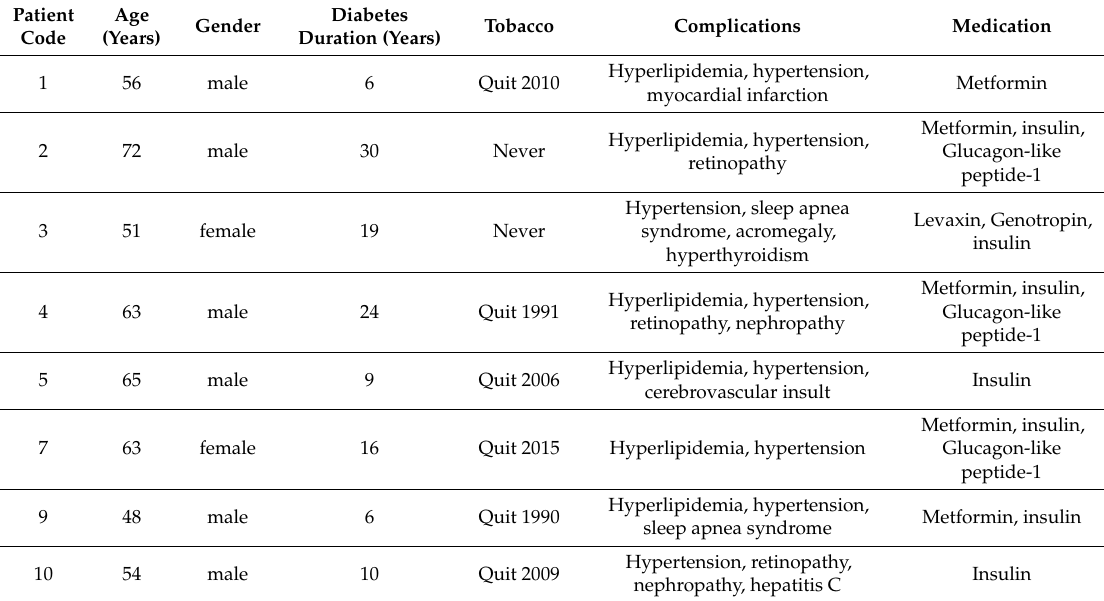
Table 1. Baseline data of the enrolled